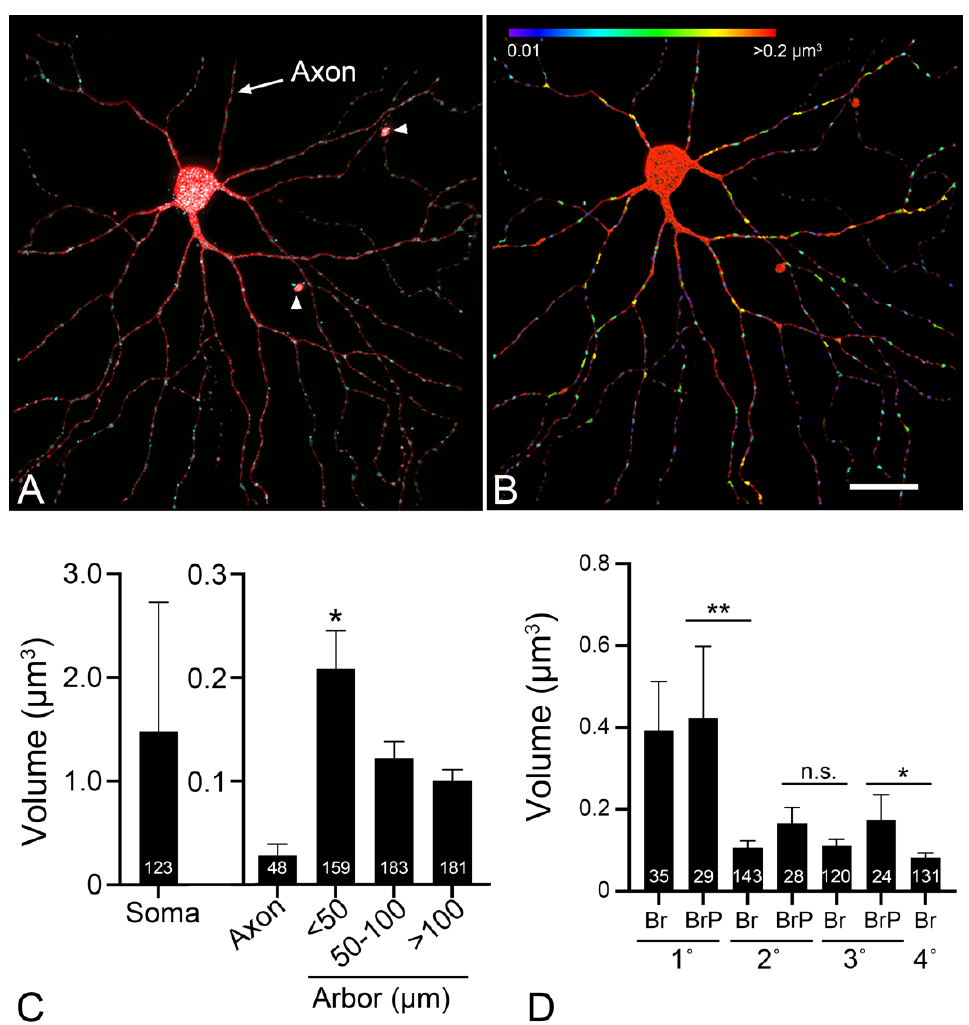
Figure 4. Mitochondrial distribution in a mouse ON- α RGC. Masked confocal Z-stack image of a single RGC from a transgenic mouse expressing Thy1-mitoCFP to identify mitochondria. The cell was labeled by biolistic transfection with a plasmid expressing tdTomato. ( A ) Merged image showing the cell fill and CFP-positive mitochondria. The intraretinal axon of the cell is identified. Additionally, the dendritic arbor exhibits two evulsions (arrowheads) that contain mitochondria (see Figure 5). ( B ) Mitochondrial volume was analyzed using the surface function of Imaris and a heat map of mitochondrial sizes was rendered. Size bar = 25 µ m. ( C ) Bar graph (mean ± standard deviation) of mitochondrial volume as a function of distance from the center of the soma in the RGC shown in ( A ). The numbers of mitochondria identified in each region is indicated in each bar. Note the change in scale of the Y-axis between the soma versus other compartments. Within the arbor, the largest mitochondria are localized within 50 µ m of the cell center (* p ≤ 0.026), relative to the two other arbor regions, which are not significantly different from each other. ( D ) Bar graph of mitochondrial volume as a function of arbor classification. Mitochondrial sizes are not significantly different in a branch (Br) and the point at which that branch splits into new branches (Branch Point-BrP), but there is typically a significant decrease in size between the proximal branch point and the distal branches (** p = 0.0002, * p = 0.016, n.s. = not